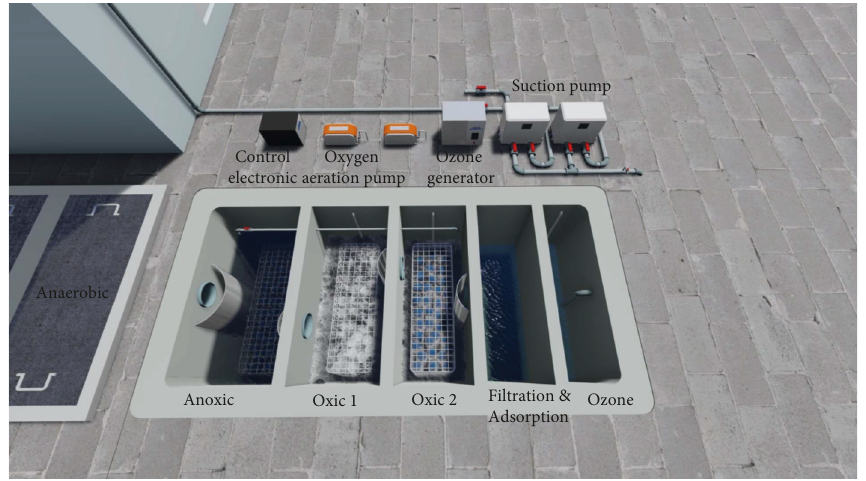
Figure 2: A simulation diagram of the AAO/O